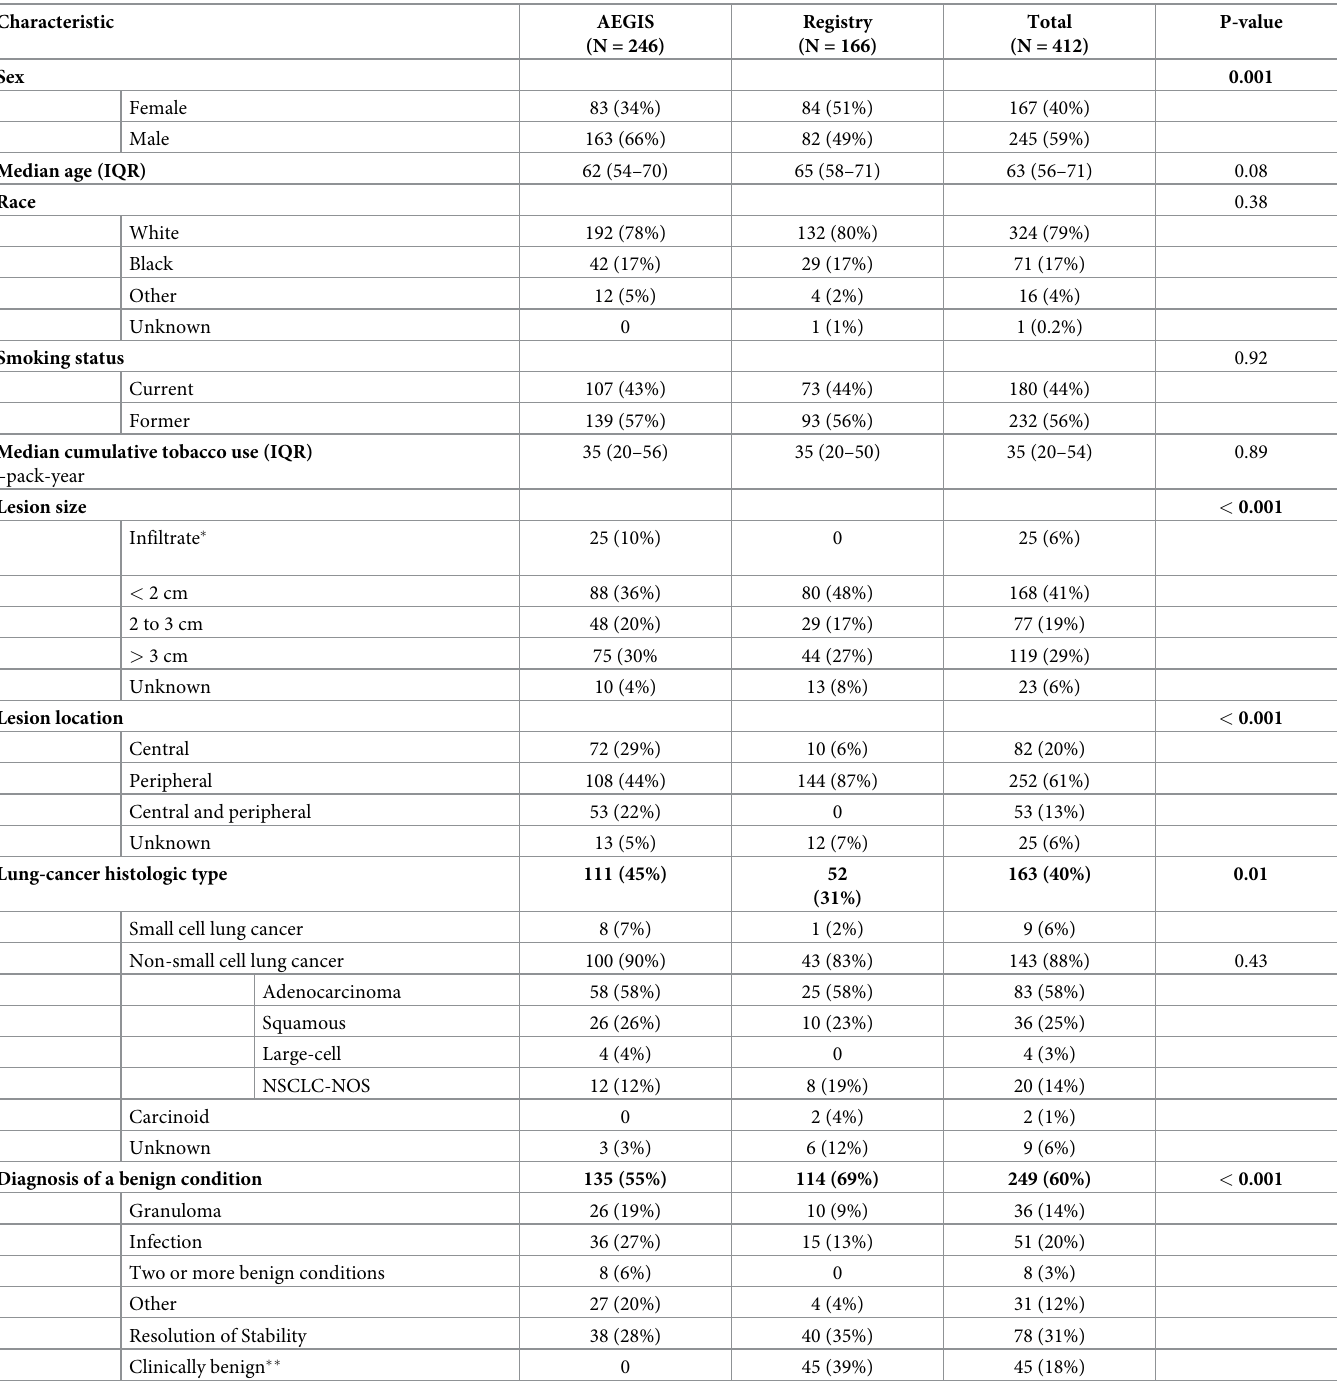
Table 1. Demographic and clinical characteristics of the study